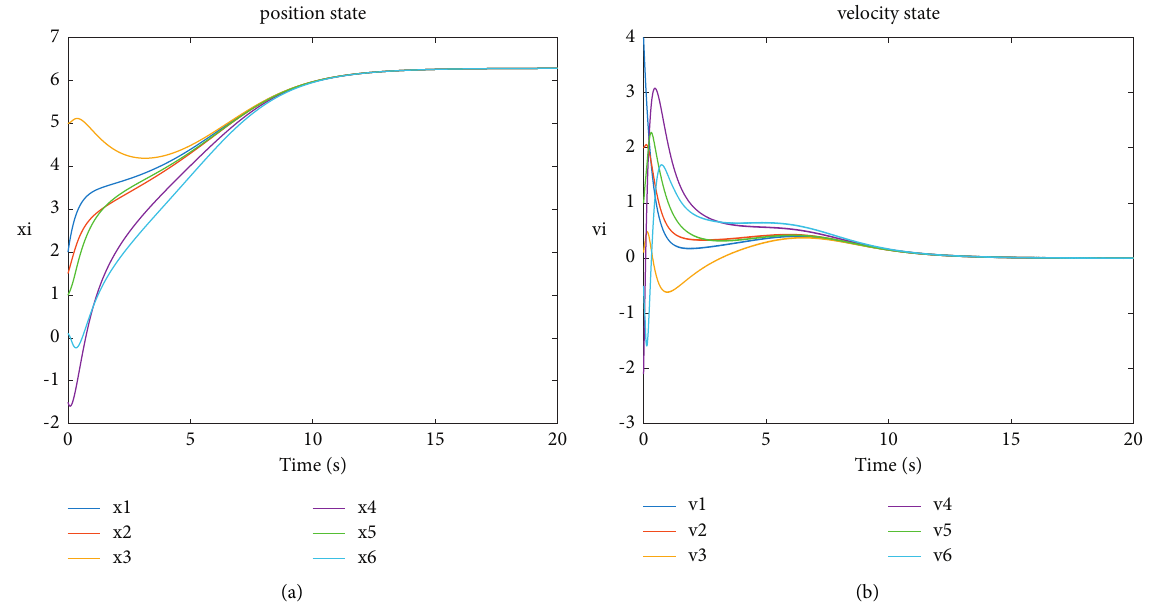
Figure 2: The state of each agent. (a) Position state of each agent. (b) Velocity state of each agent.